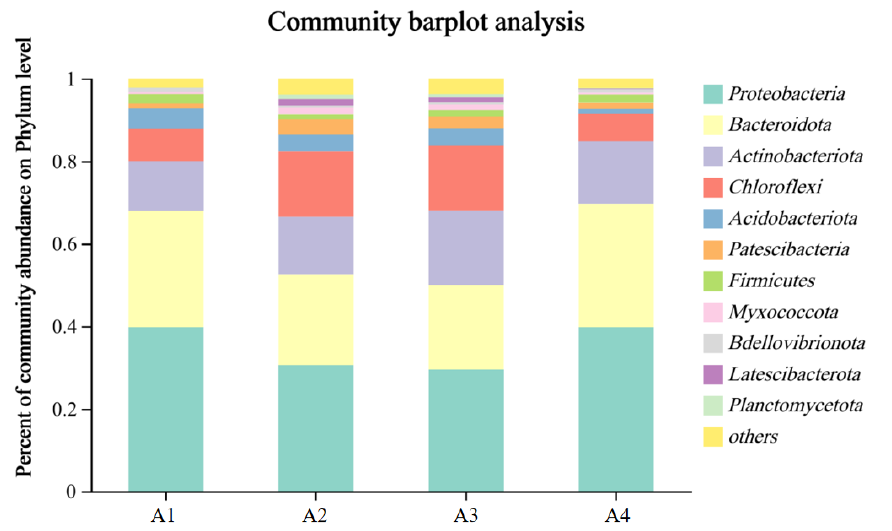
Figure 5. Evolution of microbial community structure at phylum level.